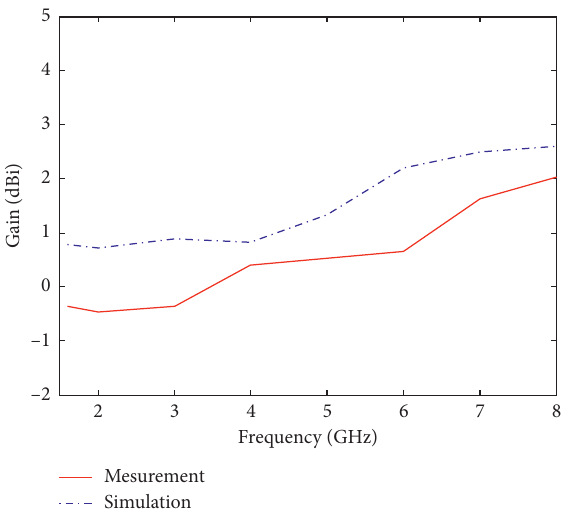
Figure 24: The simulated and measured gain of the SAAS antenna with a metallic cavity.